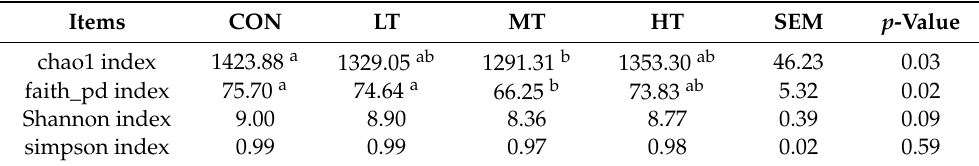
Table 3. Alpha diversity index of bacteria.